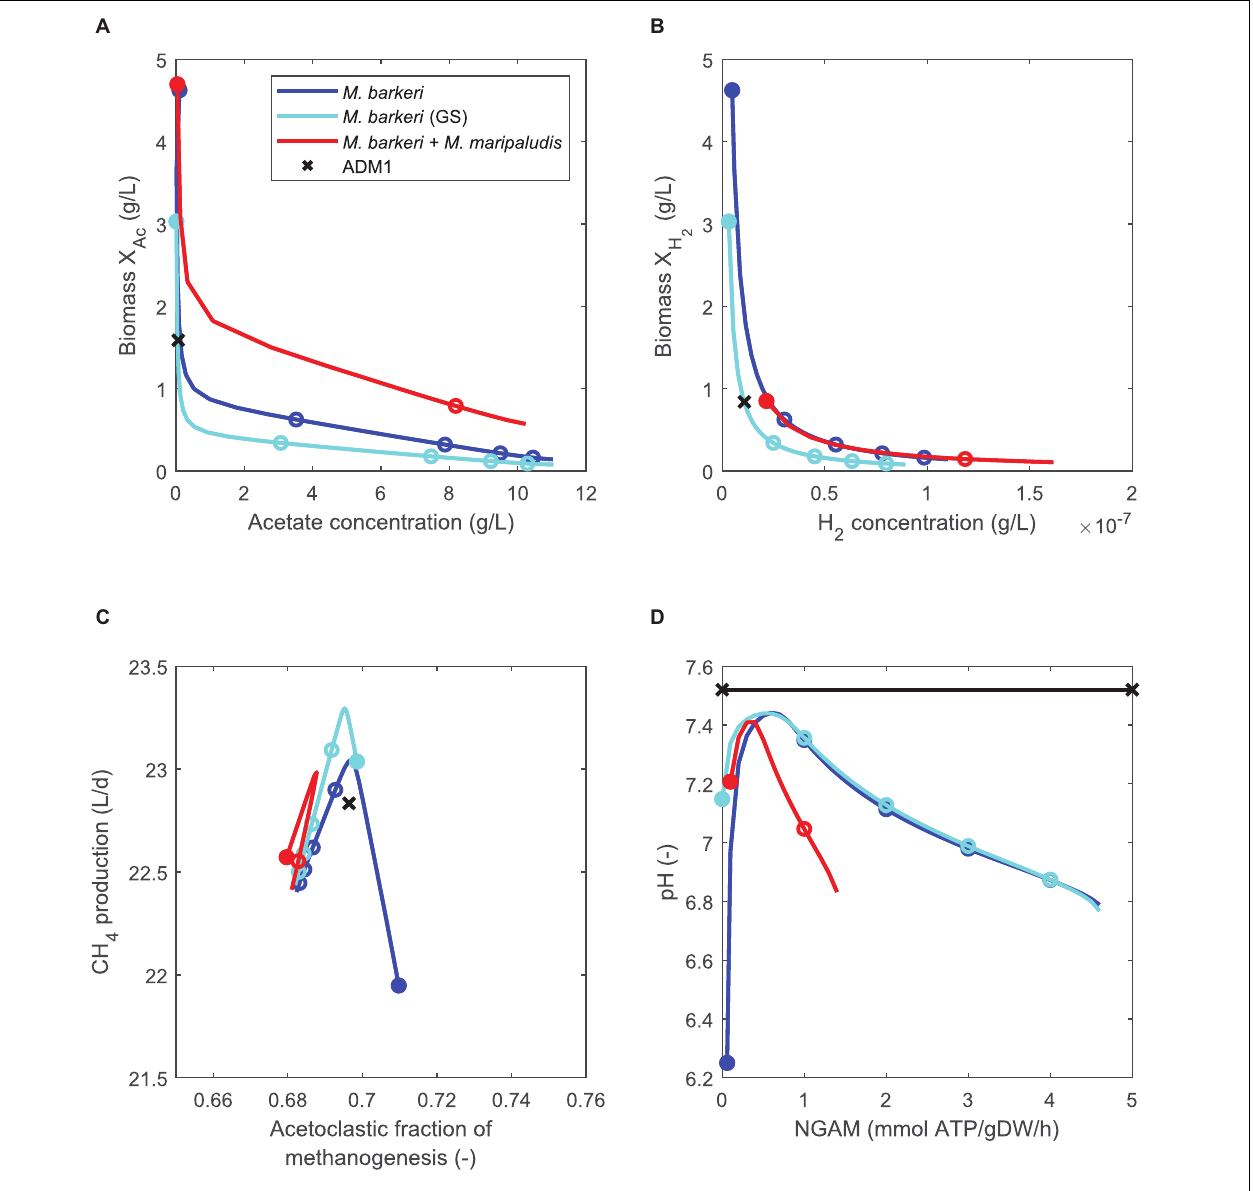
FIGURE 4 | Comparing steady-state model predictions of standard ADM1 (x) and coupled models in which the non-growth associated maintenance (NGAM) demand is varied between 0 (closed symbols) and 5 mmol ATP/gDW/h (open symbols mark increments of 1), using continuously fed maize silage as substrate. Both methanogenesis pathways are replaced by either one FBA model of M. barkeri [minimal or genome-scale (GS) model], or by two pathway-specific models. (A) Comparing biomass of acetoclastic population (X AC ) and acetate concentration. (B) Comparing biomass of hydrogenotrophic population (X H2 ) and hydrogen concentration. Note that for single FBA model coupling variants, biomass values are identical to (A) . (C) Comparing methane production rate and pathway-specific contribution to methanogenesis. (D) Comparing resulting pH as NGAM is